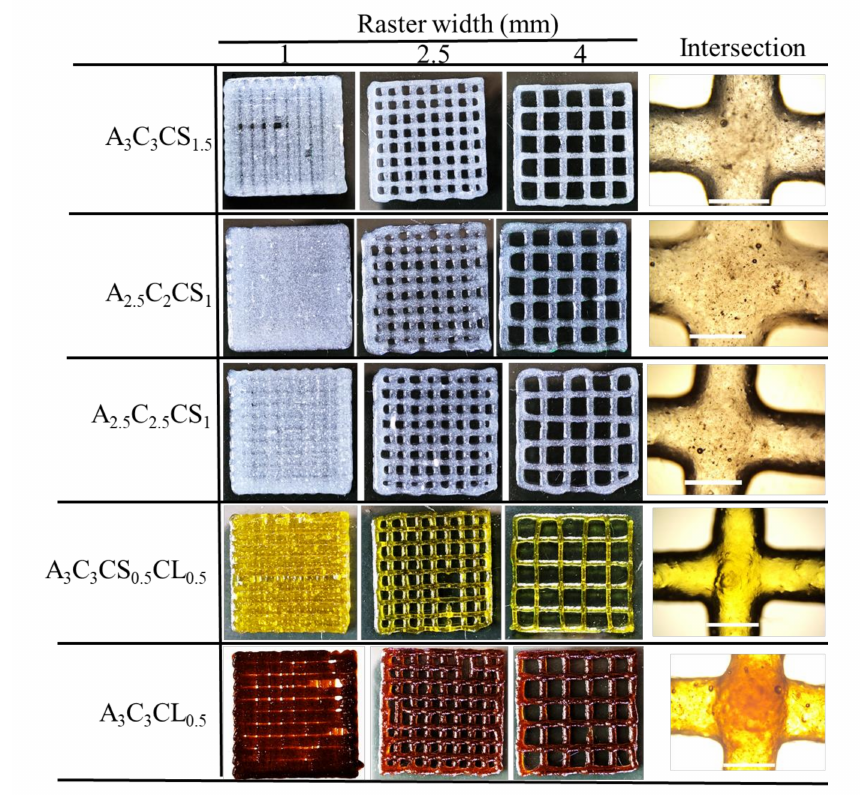
Figure 9. Bi-layer scaffolds having various raster widths and intersection of the filaments, These images were used to determine the printability of all compositions for pore size 2.5 mm × 2.5 mm, and filament widths for all compositions and compared with respect to actual nozzle